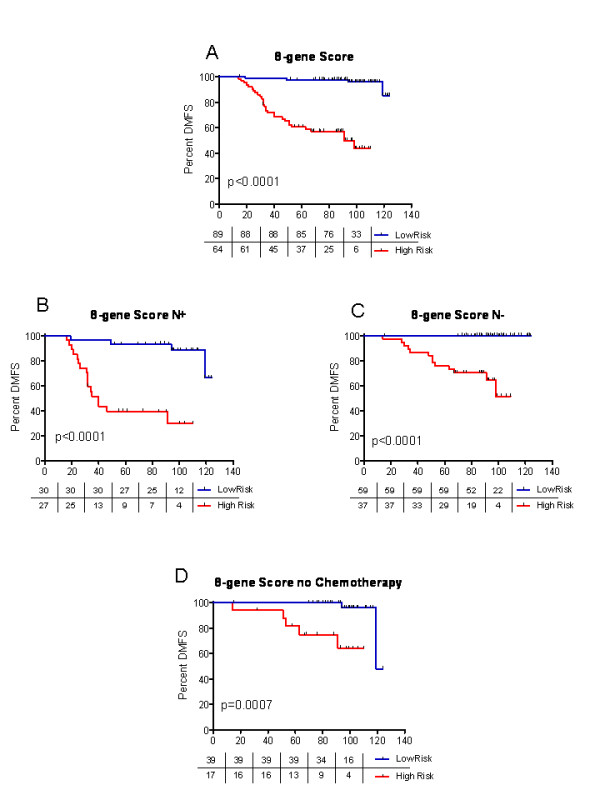
Kaplan-Meier curves showing distant metastasis-free survival (DMFS) for low-risk and high-risk patient groups (as defined by the 8-gene Score). A: all 153 patients included in this study B: patients with positive lymph nodes C: patients with negative lymph nodes D: patients who did not receive chemotherapy